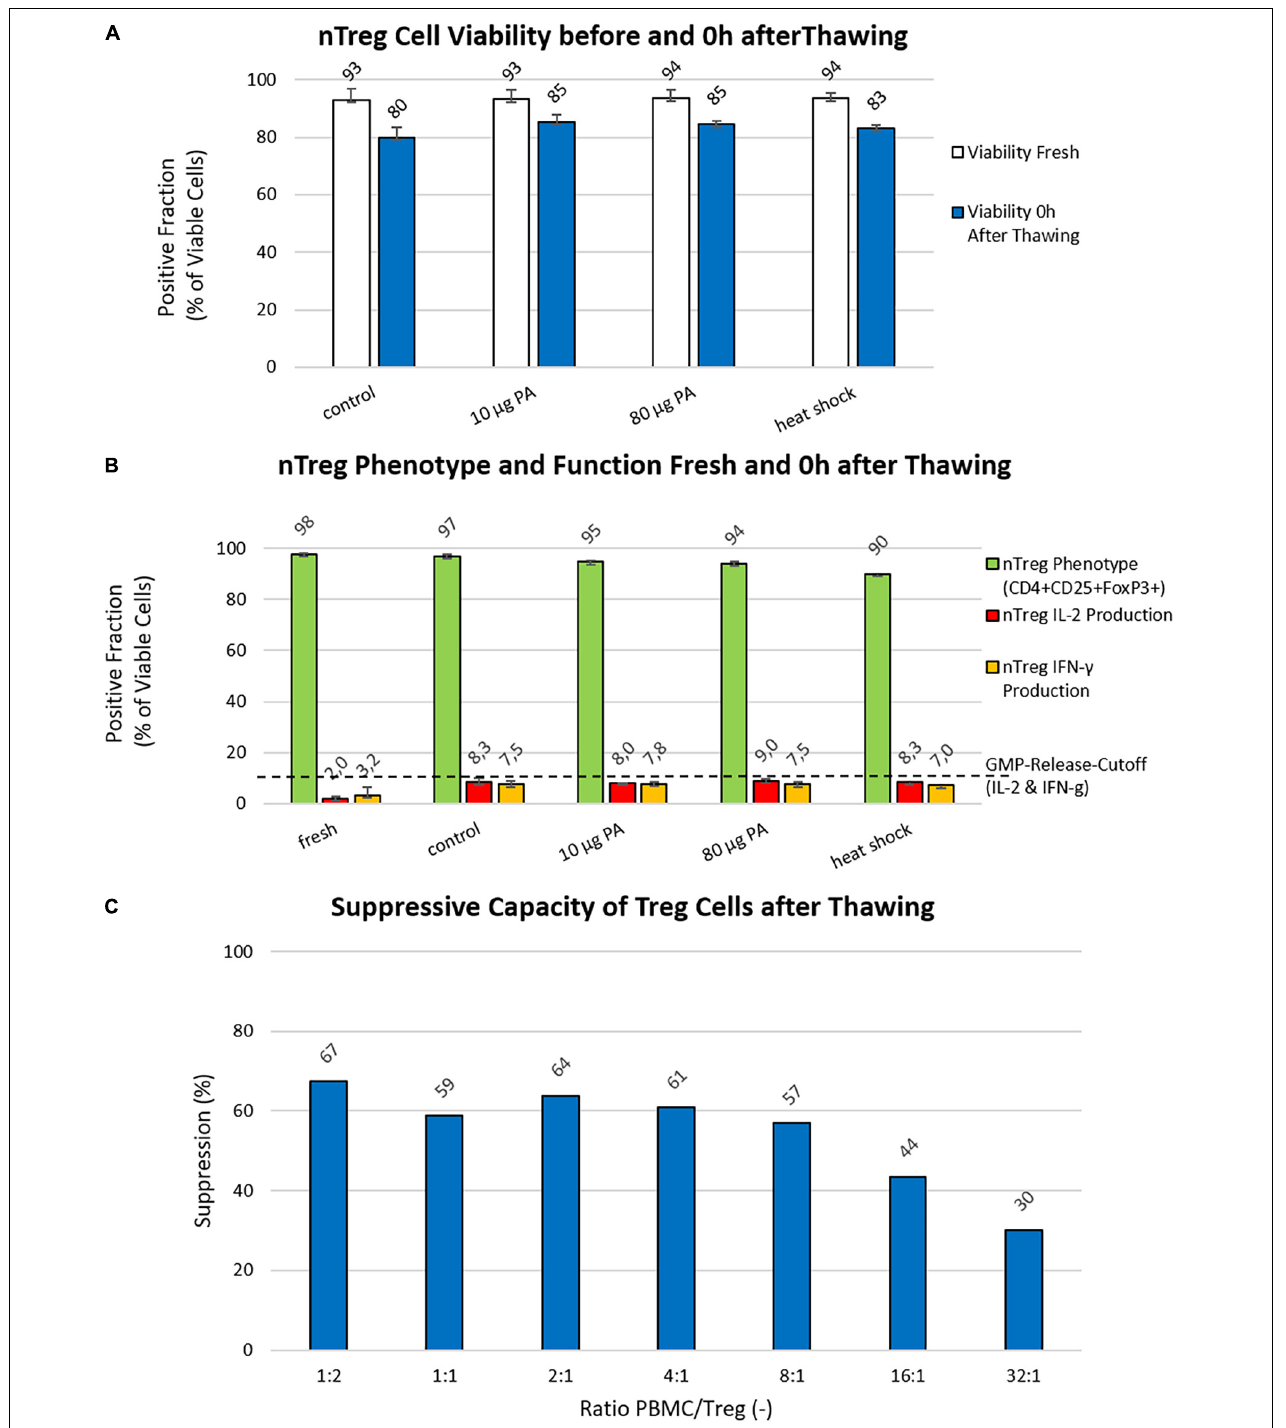
FIGURE 3 | Analysis of Cryo-/Cyto-protective pathways and suppressive potency. (A) Viability (%): The viability of nTregs before freezing (white bars) and immediately after thawing/0 h (blue bars) is shown for the control approach (freezing medium with 5% DMSO) as well as the investigated approaches with heat shock or paeoniflorin (PA; 10 µ g and 80 µ g) induction of the cell’s own protective mechanisms. Data were collected using two generated Treg products from two different donors. (B) nTreg Phenotype and Function (%): The nTreg phenotype (green bars) and function assessed as the percentage of IL-2 (red bars) and IFN-g (yellow bars) cytokine secreting cells before freezing and after thawing of the two investigated nTreg cell products are shown. Depicted are the data of the cells before freezing, the control approach with 5% DMSO in the freezing medium (Control), the heat shock, and treatment with paeoniflorin (PA; 10 µ g and 80 µ g) induction. (C) Suppression Assay: The suppressive capacity of different PBMCs to Treg ratios are shown, starting with 1:2 PBMC:Treg down to 32:1.